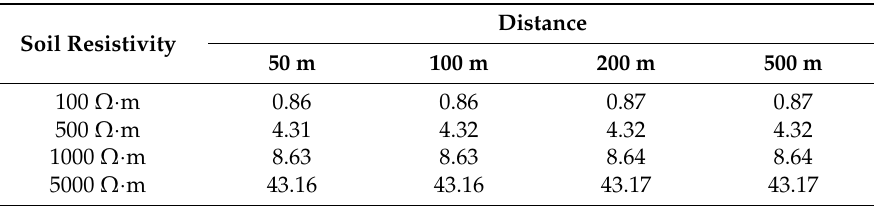
Table A2. Scenario 1b. Overall grounding resistance.